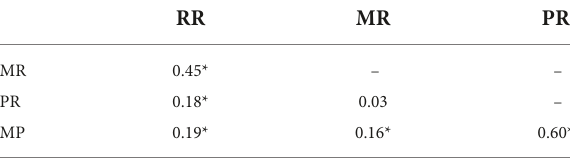
TABLE 5 Correlations between the subscales of the